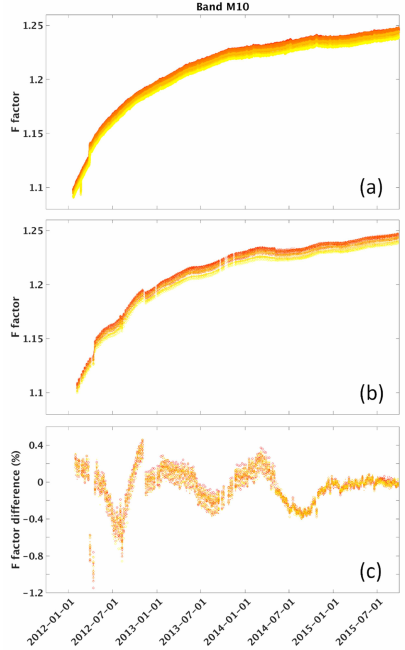
Figure A7. ( a ) VIIRS band M10 (1610 nm, single gain) radiometric calibration scaling coefficients (the F factors) derived by the automated calibration procedure; ( b ) the F factors used in the operational production of the VIIRS SDR; and ( c ) relative difference between the operational F factors and the reprocessed ones (used here as a baseline). Symbol legend is the same as in Figure 4.